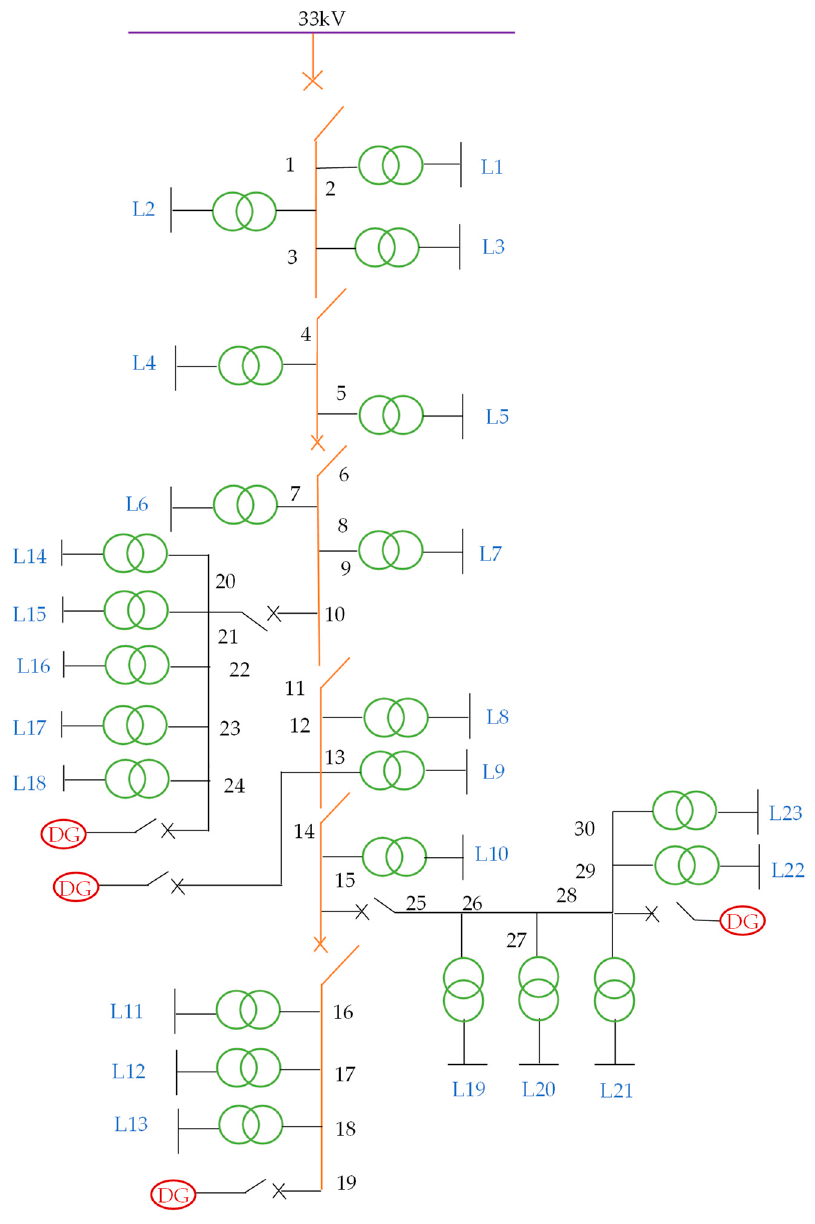
Figure 3. Distribution network reliability test system